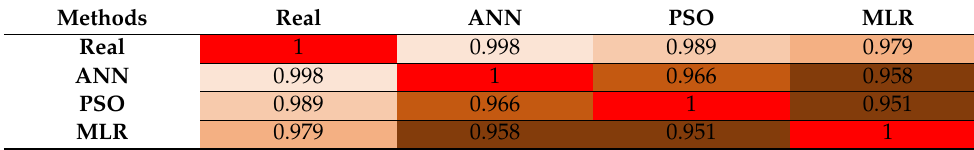
Table 6. Gokceada correlation matrix between